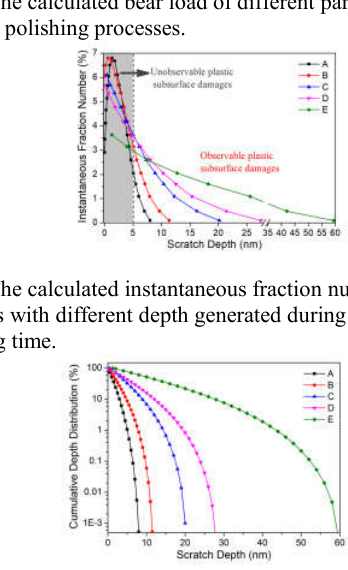
Fig. 4. The calculated final cumulative depth distribution of scratches generated during different polishing